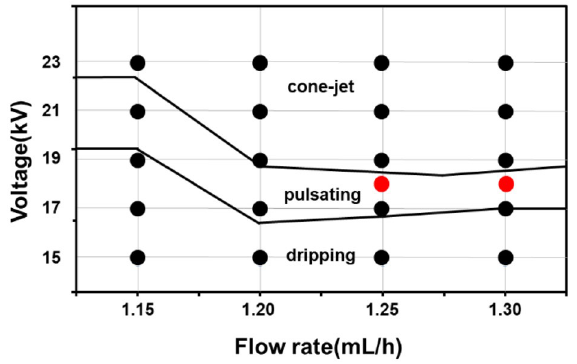
Figure 2. Experimental conditions in terms of voltage and flow rate.